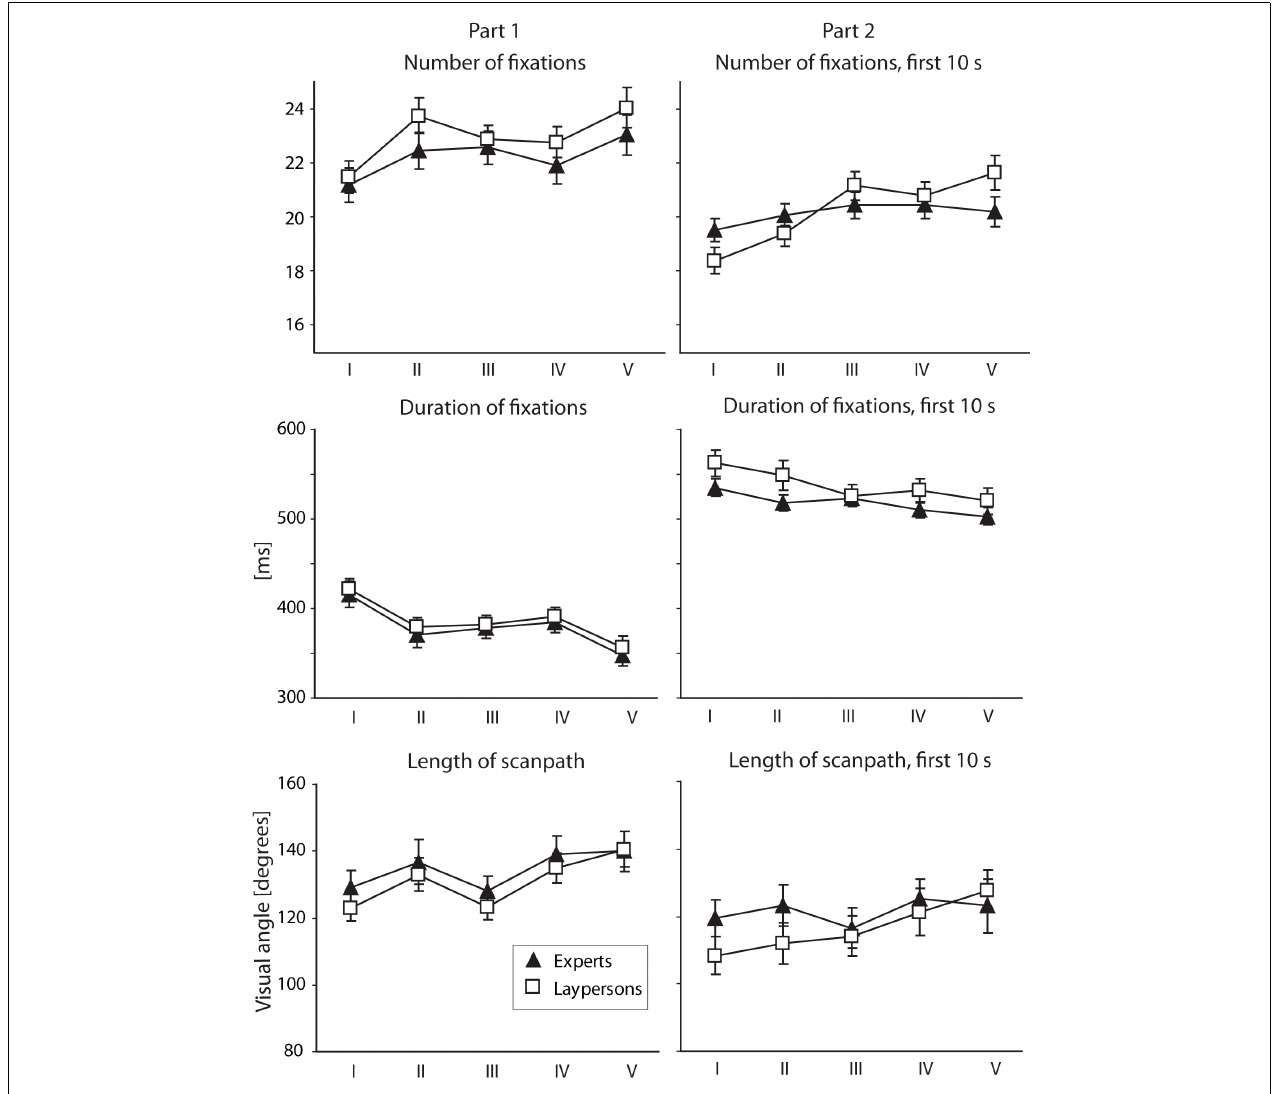
FIGURE 2 | Gaze patterns relative to the abstraction level of the paintings for Part 1 (left) and for the 10 first seconds of Part 2 (right). Average number of fixations (top row), mean duration of fixations (mid row), and total length of the scanpath (bottom row) for experts and laypersons.The error bars represent SE.